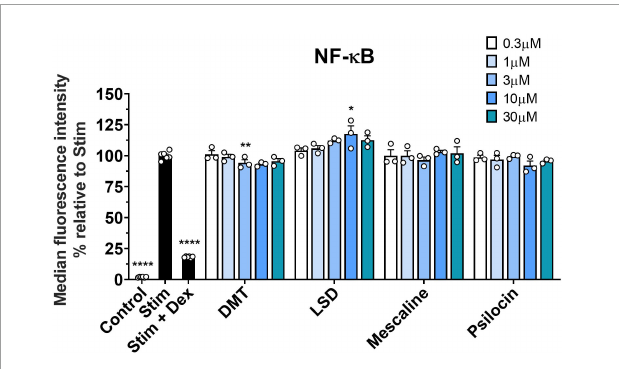
FIGURE4 Effect of classic psychedelics on the LPS-triggered GFP-NF- κ B induction of THP1 NF- κ B reporter cells. THP-1 NF- κ B-eGFP cells were stimulated with LPS (Stim) and incubated in the presence of medium alone (Ctrl) and classic psychedelics for 24 h. Dexamethasone (Dex) served as a control substance for NF- κ B inhibition. Data represent the mean ± SD from four independent experiments. Data were analyzed by one-way ANOVA followed by Dunnett’s T3 multiple comparison test (**** P < 0.0001, ** P < 0.01, * P < 0.05 when compared to stimulated cells without drug